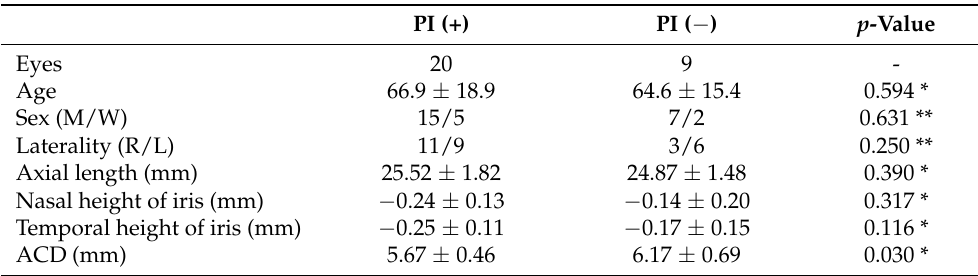
PI = peripheral iridectomy, M = man, W = female, ACD = anterior chamber depth, * = Mann – Whitney test, ** = Fisher’s exact probability test .